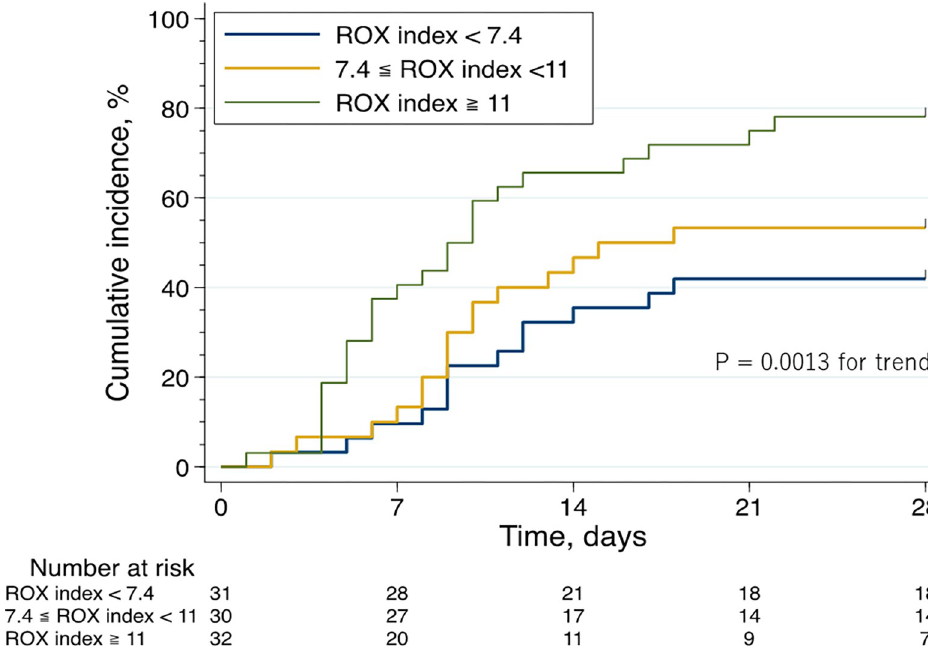
Fig 3. Kaplan–Meier curve analysis for the 28-day ventilator liberation stratified by the ROX index.